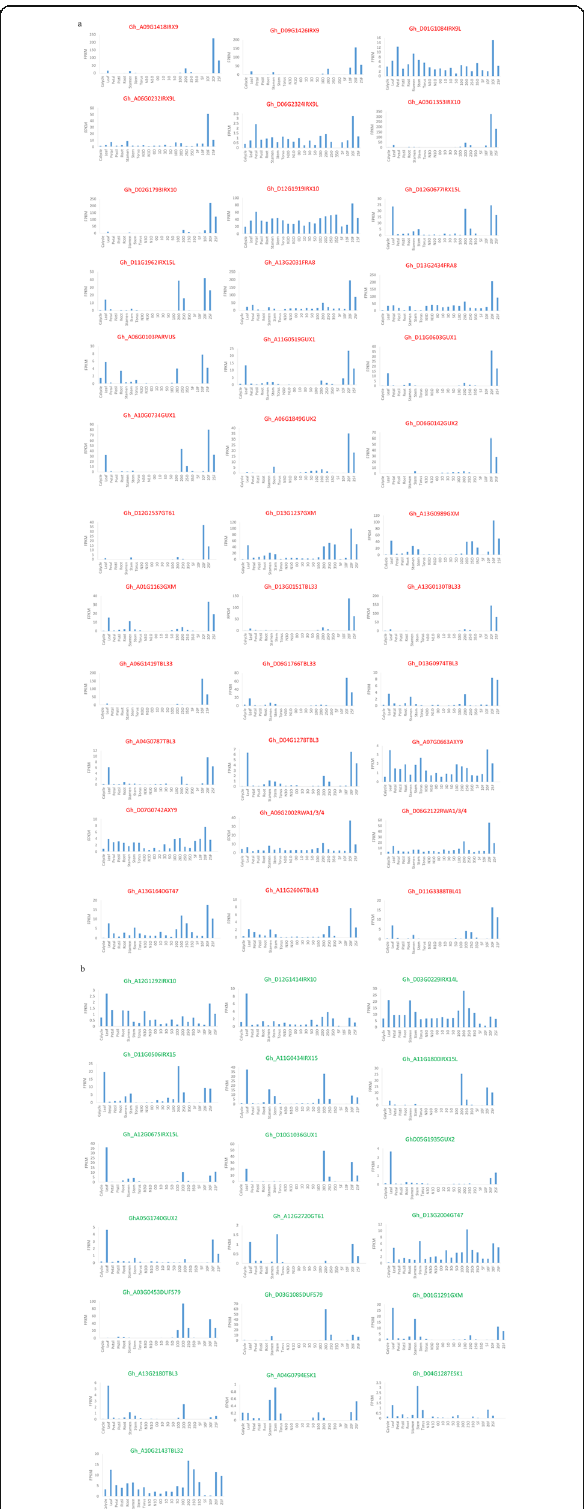
Fig. 2 Expression profiles of 55 fiber xylan synthesis-associated candidates in different cotton tissues. a 36 fiber xylan synthesis-associated candidates showed greatest expression in 20 DPA fiber. b 19 fiber xylan synthesis- associated candidates were expressed highly in 20 DPA fiber. -3O:Ovule in 3days before-anthesis; − 1O:Ovule in 1day before-anthesis; 0O:Ovule